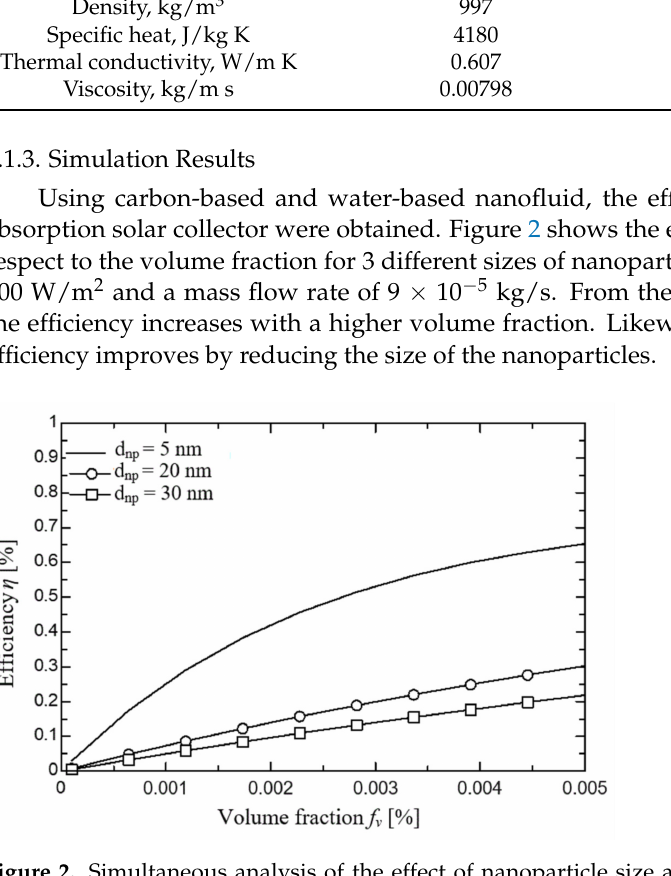
Figure 2. Simultaneous analysis of the effect of nanoparticle size and volume fraction on LTSC performance.